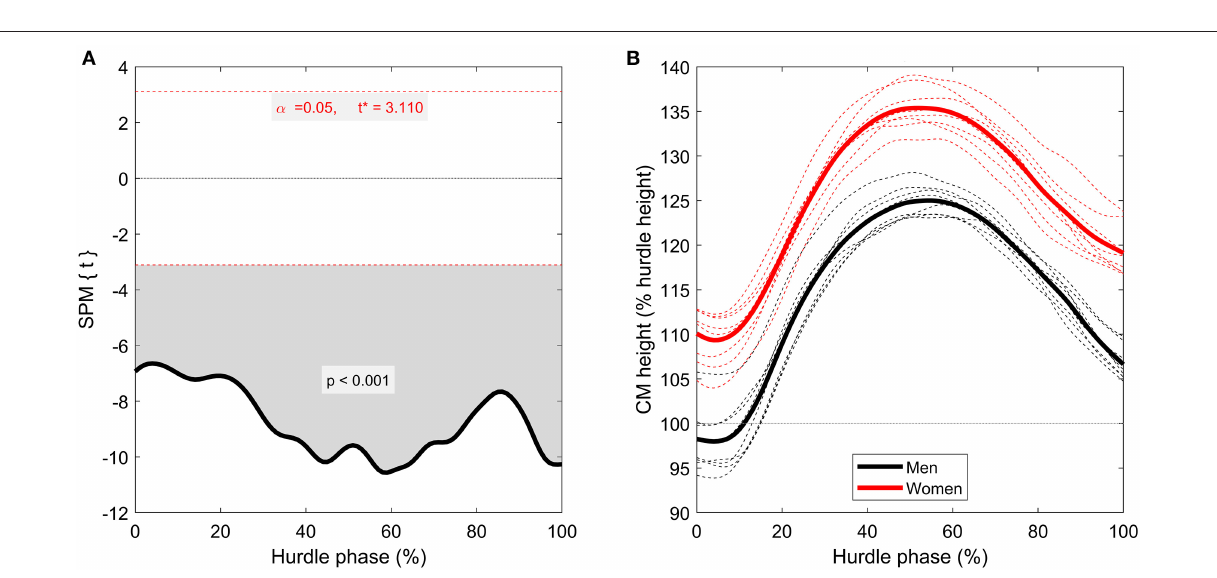
FIGURE 5 | Time-series comparison between men and women for CM height (computed as a percentage of hurdle height). The left-hand figure (A) contains the SPM t -statistic curve, and the right-hand figure (B) contains grouped mean curves (thicker, solid lines) as well as individual athlete data (thinner, dashed lines) for men (black lines) and women (red lines). There is no gray-shaded region on this occasion, as the whole time-series curve exceeded the critical t -statistic